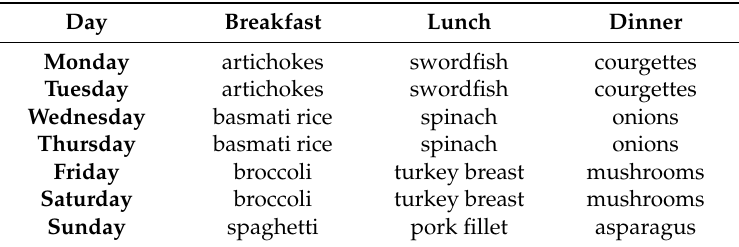
Table 1. Examples of menus in the rapid weight-loss phase.